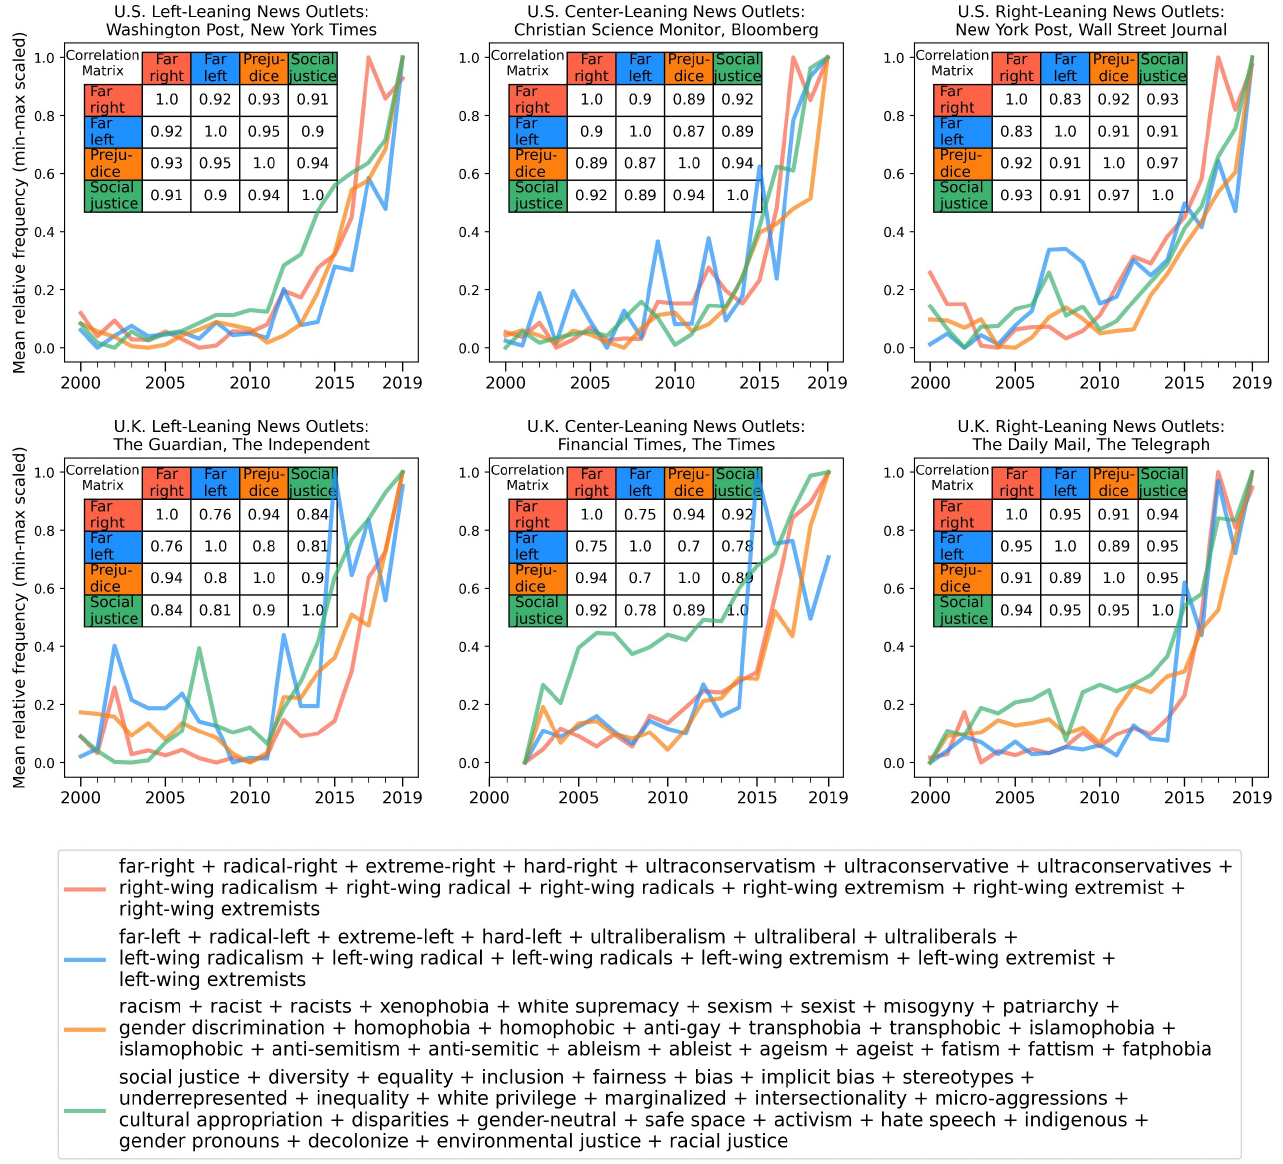
Figure 8. Yearly aggregate frequencies (min-max scaled) of sets of related terms denoting right/left political extremism, prejudice and social justice discourse in popular U.S. and U.K news outlets arranged by ideological orientation. The correlation matrix shows the Pearson correlation coefficient between the four time series.